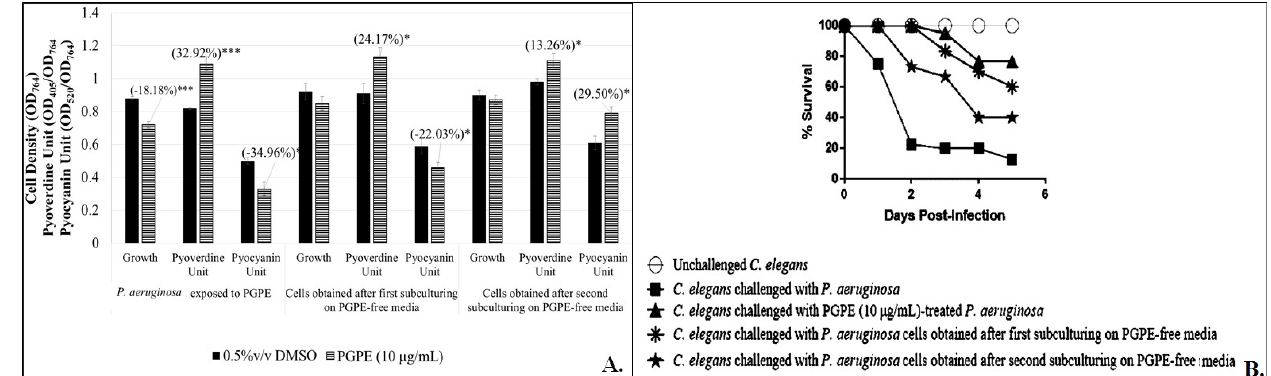
Figure 3. Post extract effect of PGPE (10 μg/ml) on P. aeruginosa . ‘Control’ in this figure is the vehicle control (0.5%v/v DMSO), which did not exert any effect on growth and pigment production of P. aeruginosa . ( A ) Effect of PGPE on growth and QS-regulated pigment production